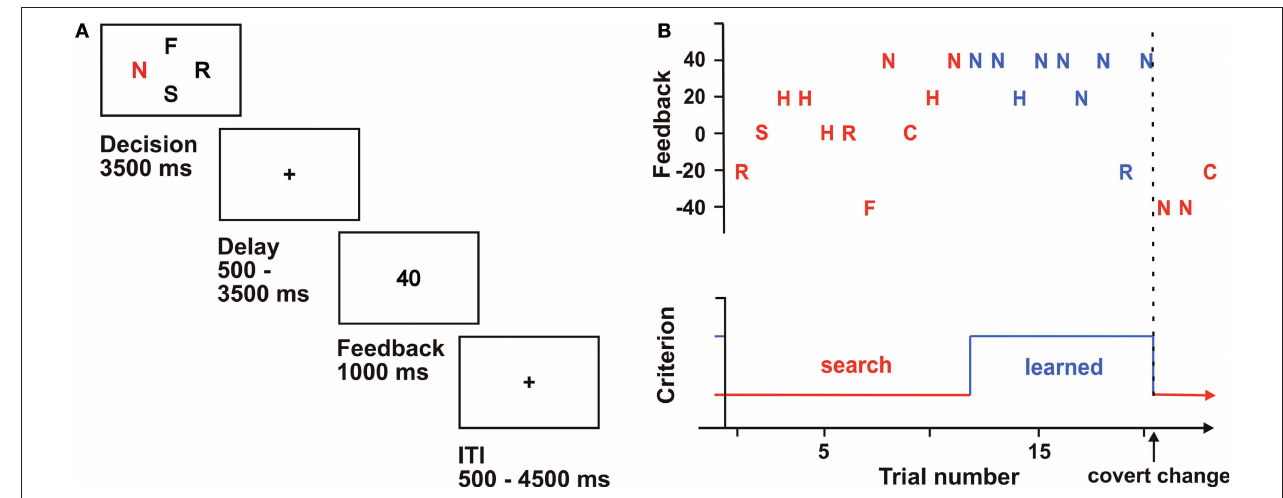
FIGURE 1 | Probabilistic object reversal task. (A) Experimental design: Participants chose one of four letters presented for 3.5 s (letter chosen marked red). After a randomized delay, abstract non-monetary feedback cues